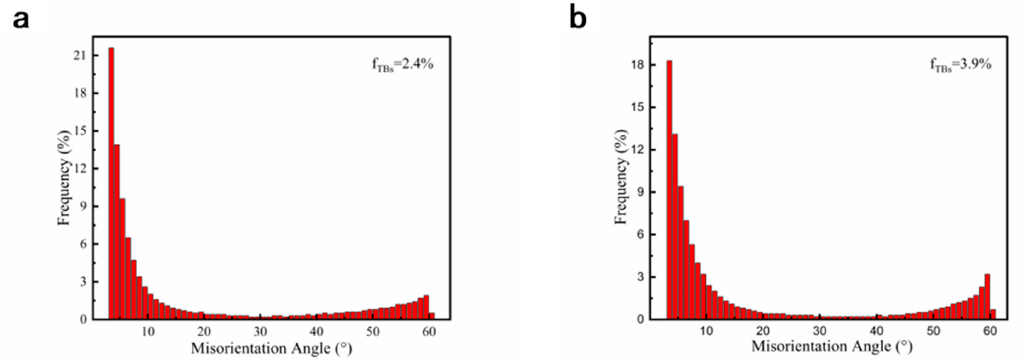
Figure 8. Distribution of boundary misorientation angle of ( a ) RTR and ( b ) CTR Cu-Ti-Cr-Mg alloy